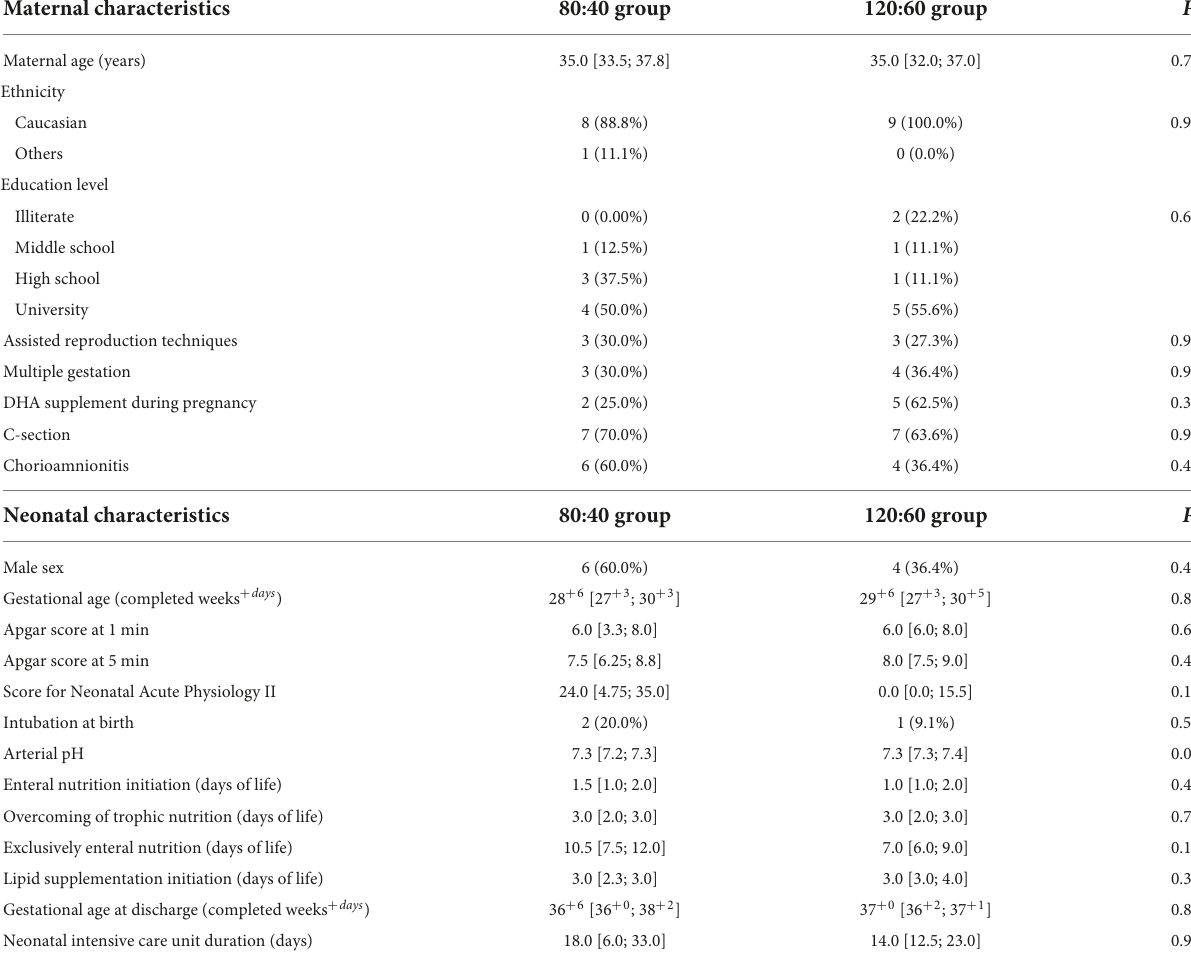
TABLE 1 Maternal and neonatal characteristics, and nutritional intakes according to the ARA:DHA group supplementation. Maternal